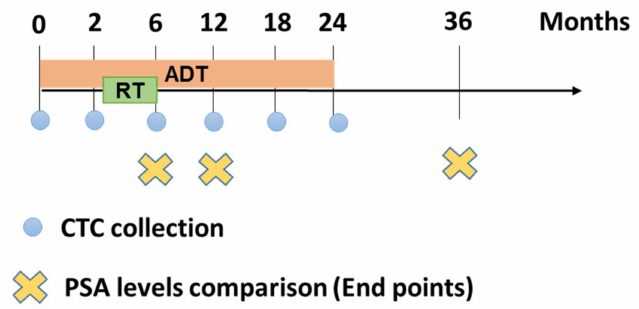
Figure 1. Summary timeline of treatment and PSA / CTC collection points over the course of the study. CTCs were collected and analyzed at 0 m (untreated), 2 m, 6 m, 12 m, 18 m and 24 months and PSA end levels at 6 months ADT, 6 months after finished RT and 36 months after initial treatment were used as early surrogates of treatment